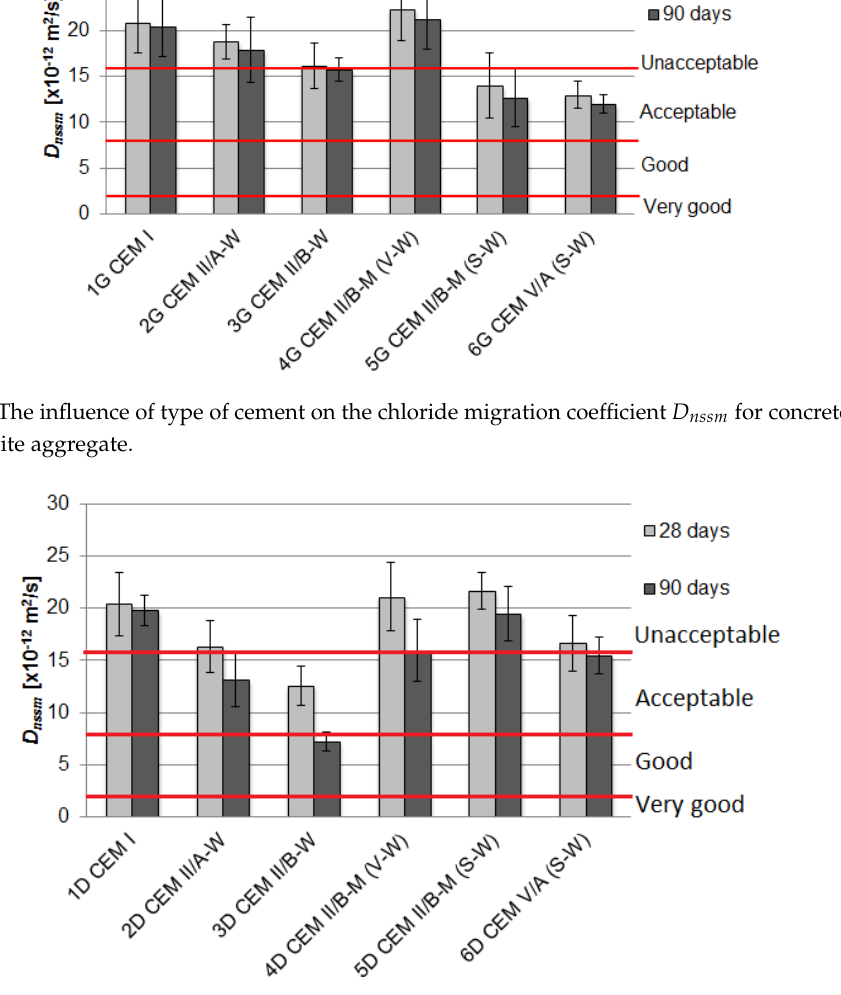
Figure 2. The influence of type of cement on the chloride migration coefficient D nssm for concrete with limestone aggregate.